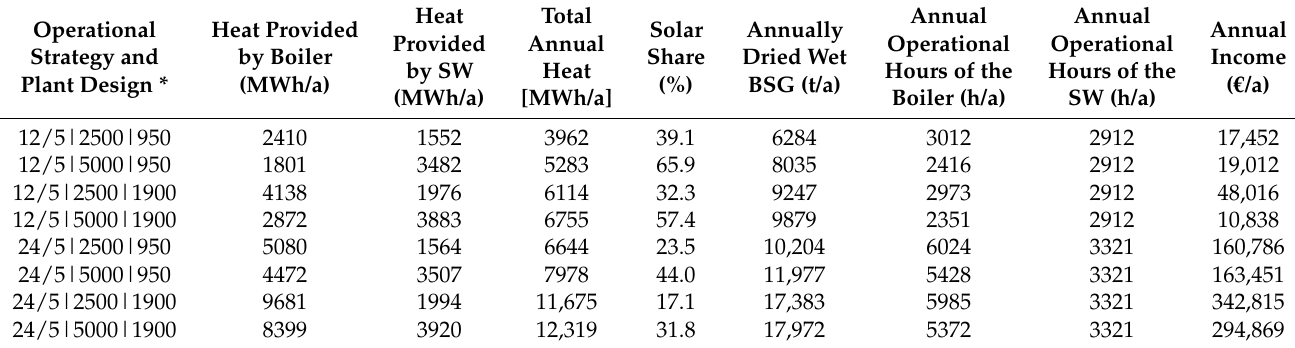
Table 7. The results obtained from different plant capacities and operational strategies 12/5 and 24/5. Operational Strategy and Plant Design